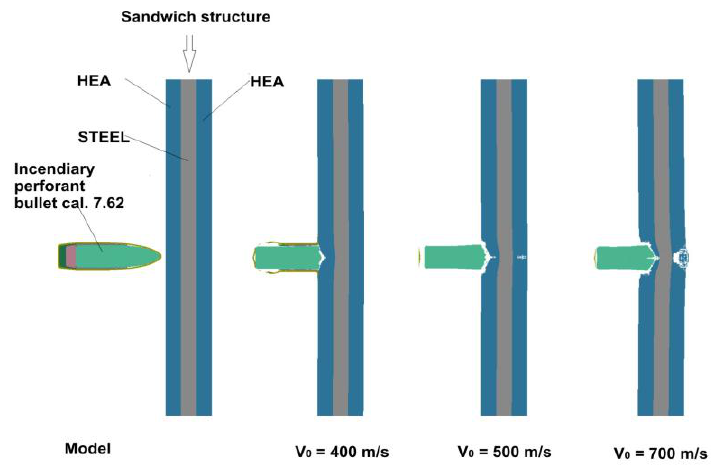
Figure 14. The behavior of the HEA-STEEL composite structure, free on contour, at impact with an incendiary armor piercing bullet (7.62 mm caliber) with different initial speeds.